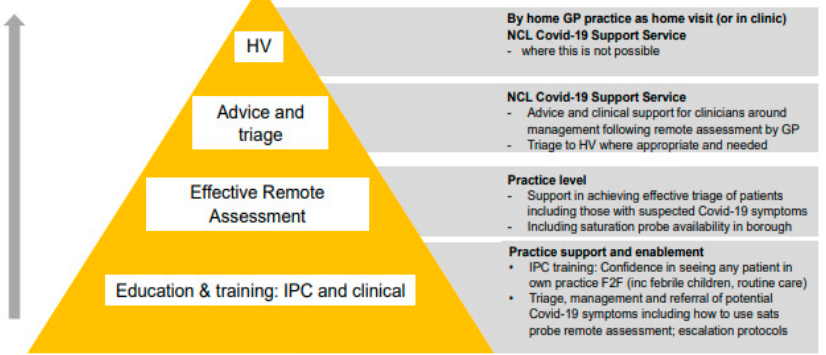
Figure 4. Model and principles of the North Central London (NCL) COVID-19 support service .